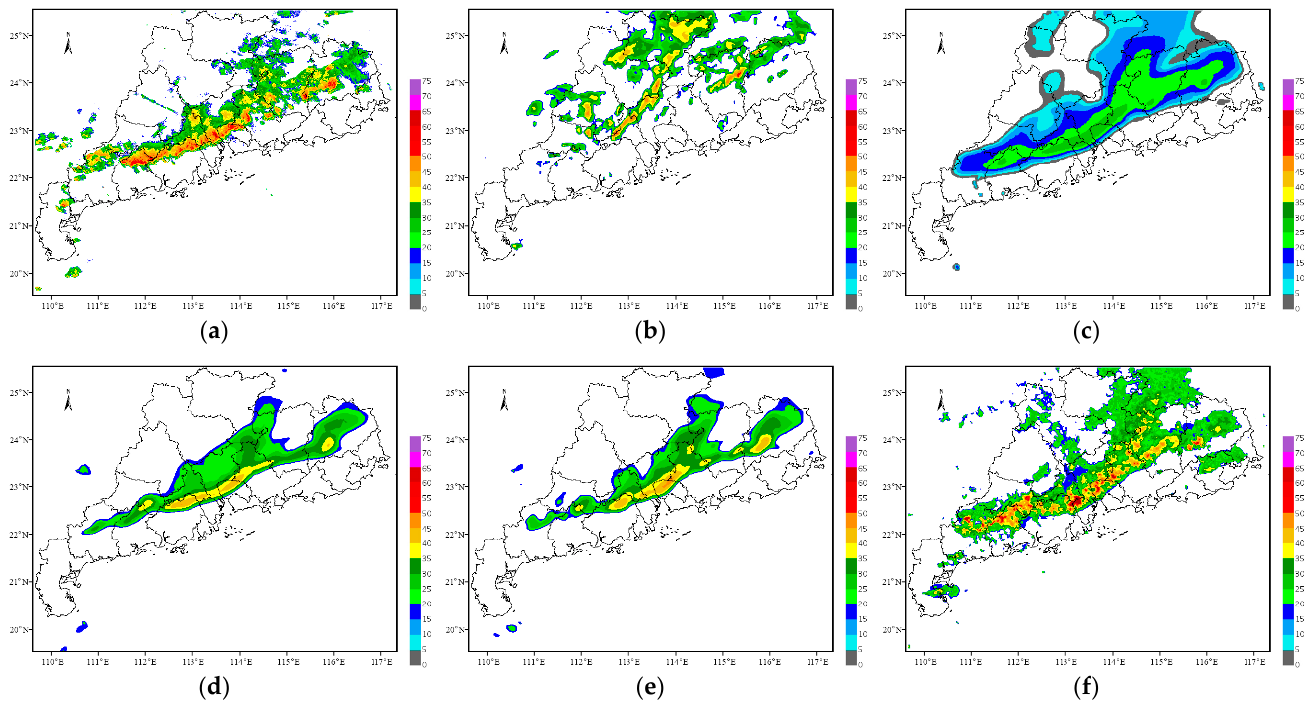
Figure 7. Nowcasting results of the squall line process for the next 2 h. ( a ) Observation; ( b ) Opti- calflow; ( c ) ConvGRU; ( d ) PredRNN; ( e ) PredRNN V2; ( f )